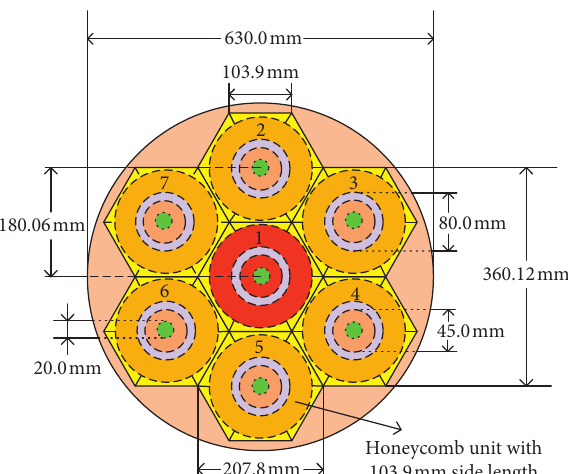
Figure 12: Distribution of two layers with seven-node honeycomb-structured ultrasound vibration network.